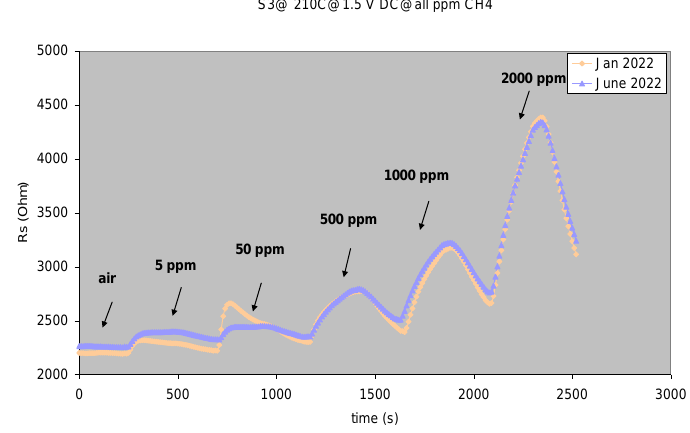
Figure 7. S3 sensor stability test (6-month period).